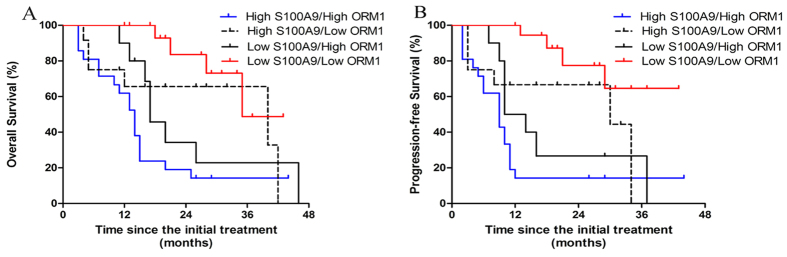
The significance of combination of S100A9 and ORM1 in survival.(A) Patients with high S100A9/high ORM1 had poor 2-year overall survival (p < 0.005). (B) Patients with high S100A9/high ORM1 had poor 2-year progression-free survival (p < 0.005).